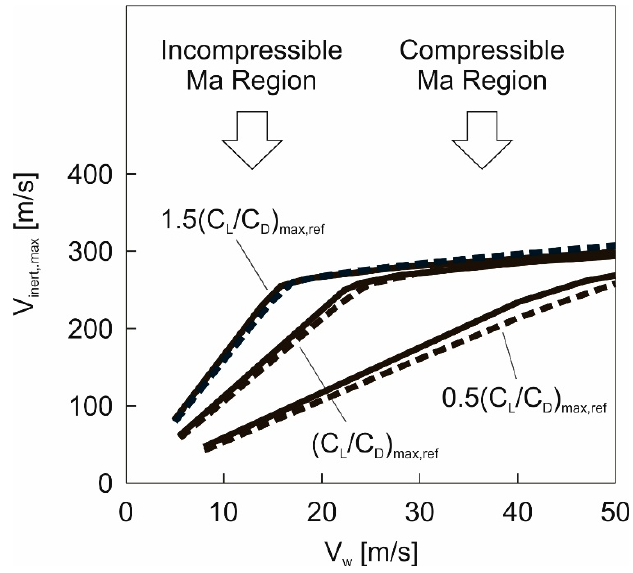
Figure 11. Maximum speed, 𝑉 (cid:3036)(cid:3041)(cid:3032)(cid:3045)(cid:3047),(cid:3040)(cid:3028)(cid:3051) , dependent on wind speed, 𝑉 (cid:3050) and on maximum lift-to-drag ratio, (𝐶 (cid:3013) /𝐶 (cid:3005) ) (cid:3040)(cid:3028)(cid:3051) . Results obtained using the energy model, Equation (20). Results obtained using the 3-DOF dynamics